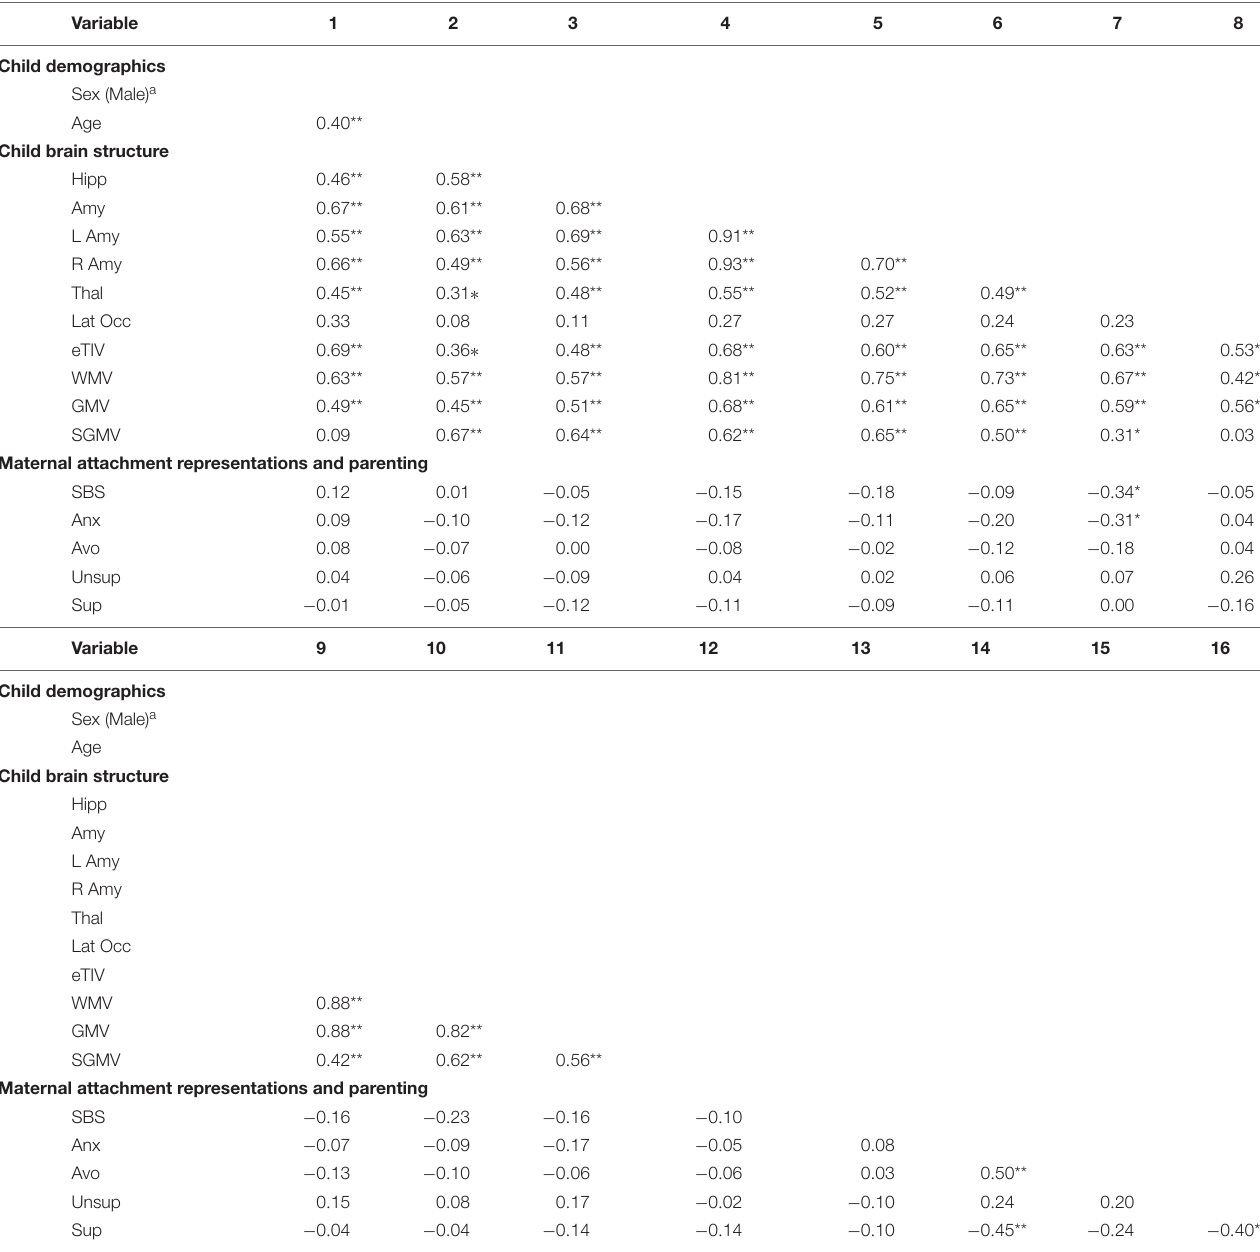
TABLE 2 | Bivariate correlations among main study